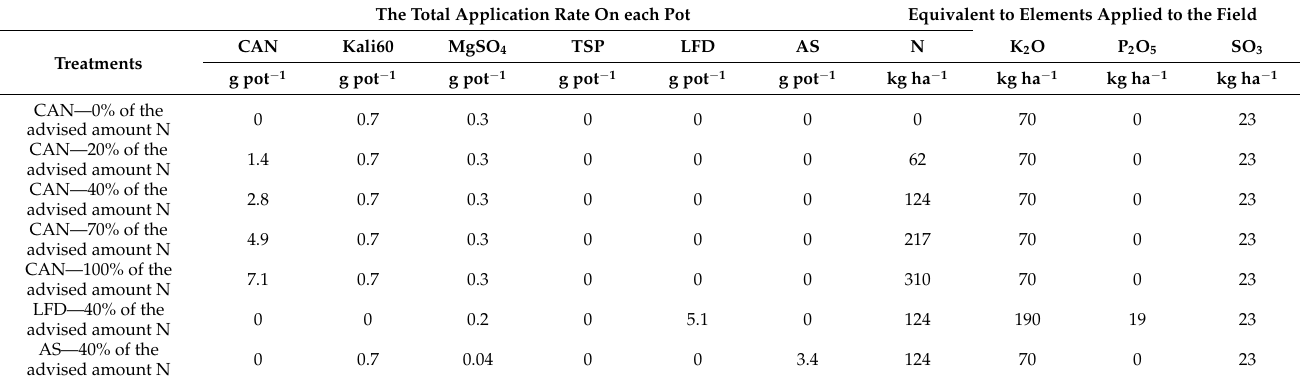
Table 3. The fertilisation scheme of the N-treatments and the equivalent amount of nutrients applied in the different treatments of the pot experiment.